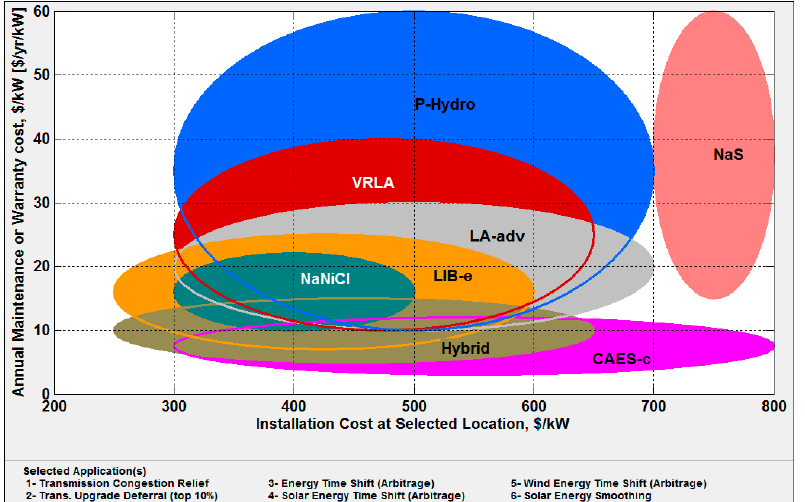
Figure 11. Annual maintenance costs or warranty for various ESSs (USD/kW) or (USD/year/kW) as a function of total installation cost (USD/kW) at the selected location.